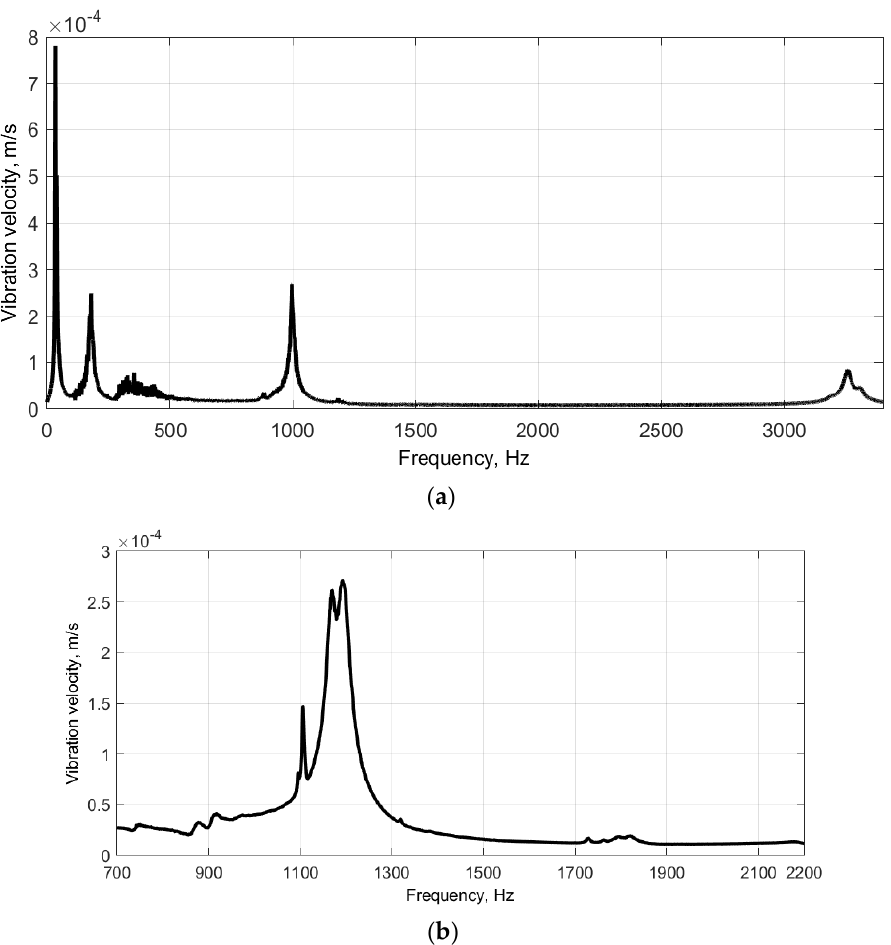
Figure 7. The FRFs of the larger ( a ) and smaller ( b ) disks. Table 1. Natural frequencies of vibration of the tested disks corresponding to mode shapes presented in Figures 8 and 9.